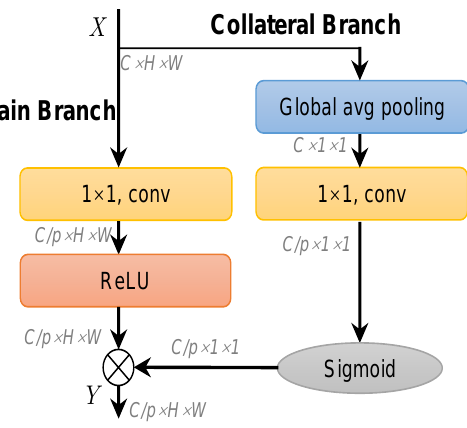
Figure 7. Implementation of dimension reduction squeeze-and-excitation (DRSE) in the MRFFR.